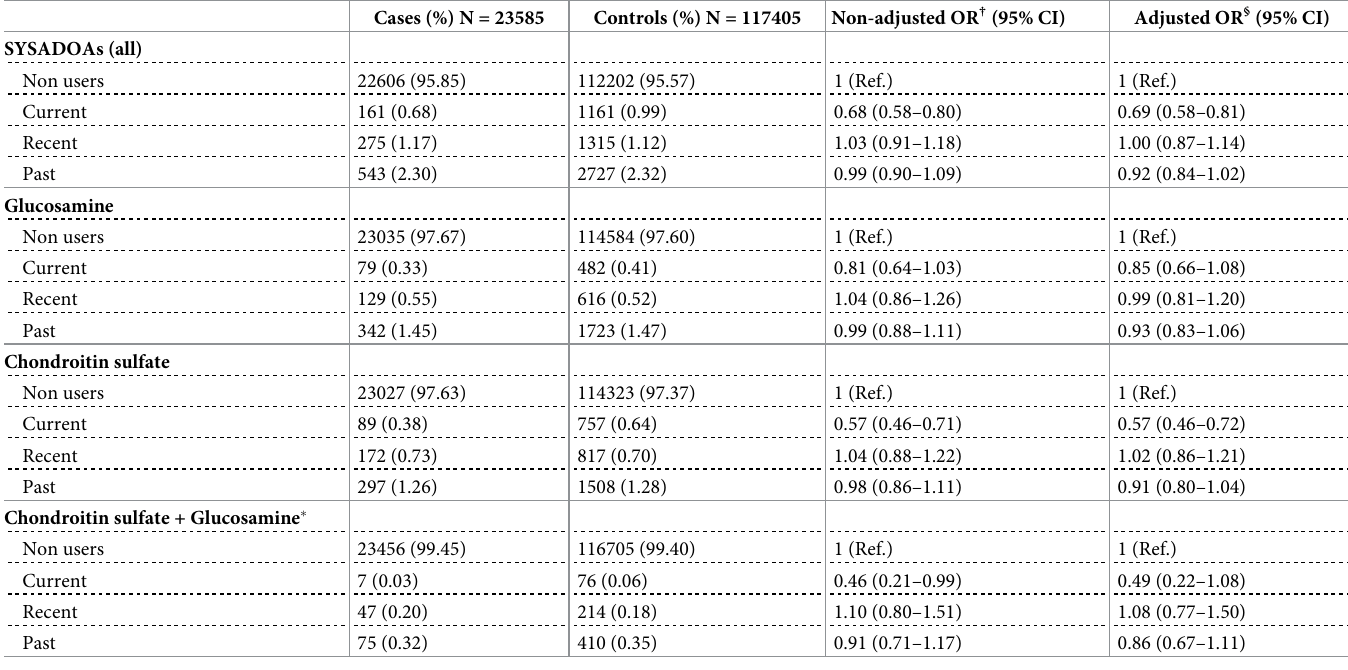
Table 2. Risk of AMI associated with the use of